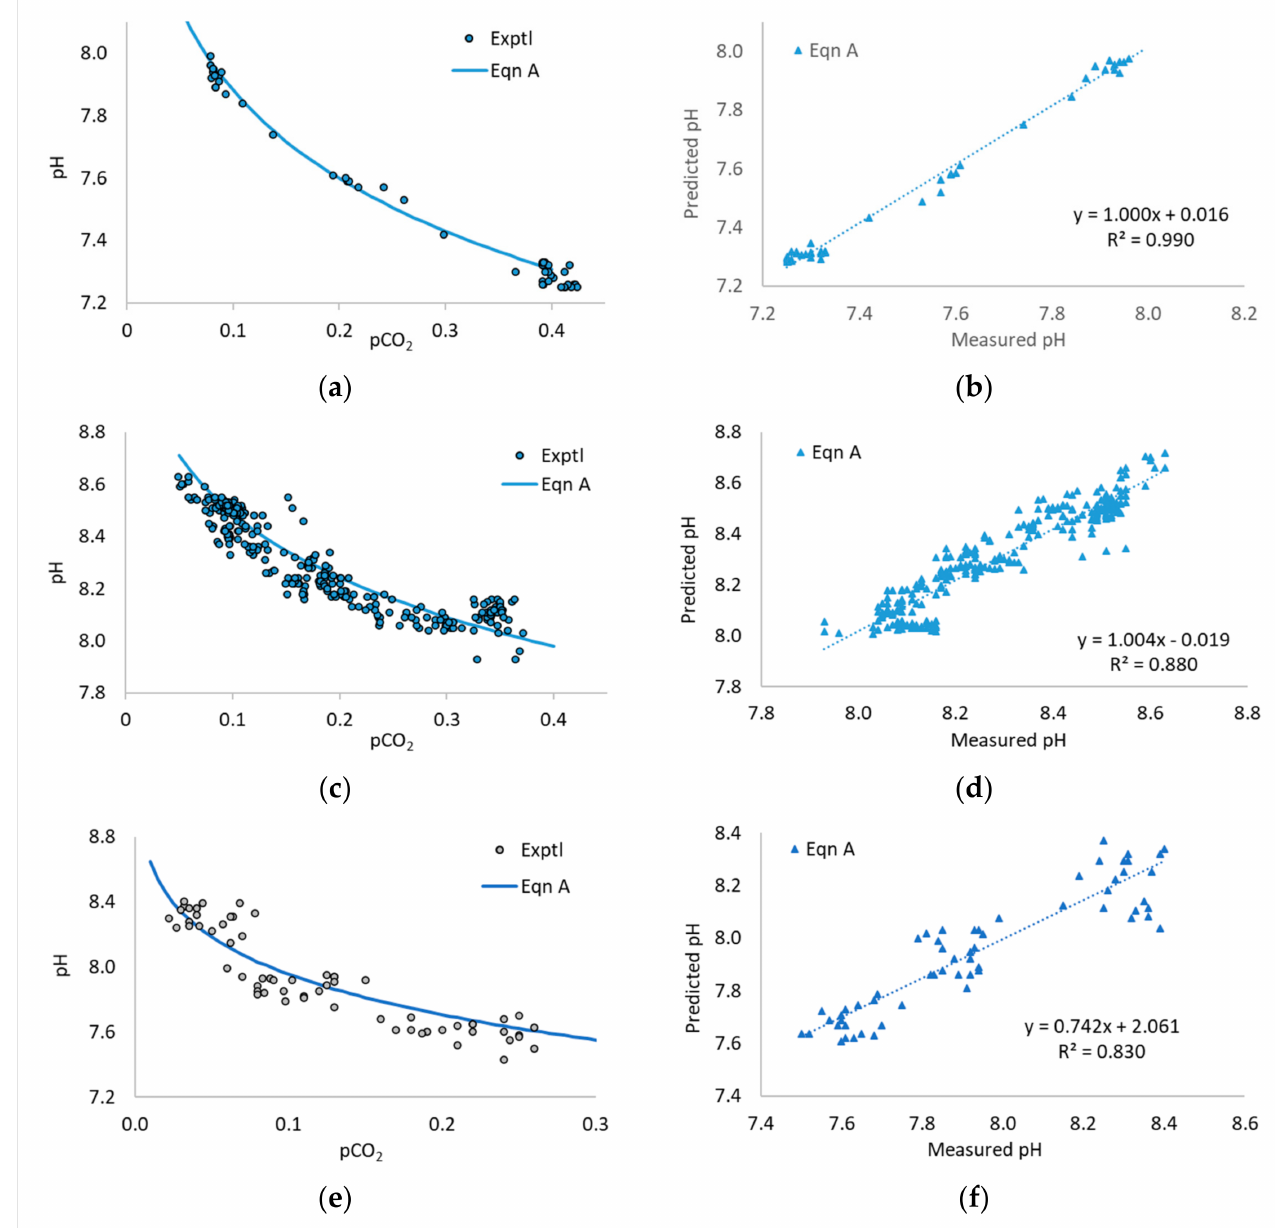
Figure 1. Experimental pCO 2 and pH values and predicted pH from Equation A for mesophilic CO 2 biomethanisation of sewage sludge ( a , b ) as reported in [6]; mesophilic CO 2 biomethanisation of industrial food waste ( c , d ) as reported in [6]; and thermophilic CO 2 biomethanisation of cattle manure ( e , f ) as reported in [40]. Numerical datasets were kindly provided by the authors in each